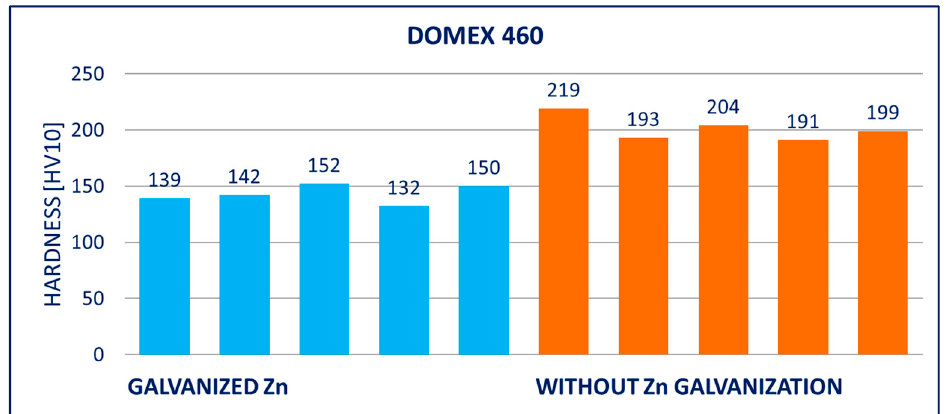
Figure 11. Results of hardness HV10 of specimens of DOMEX 460 steel.